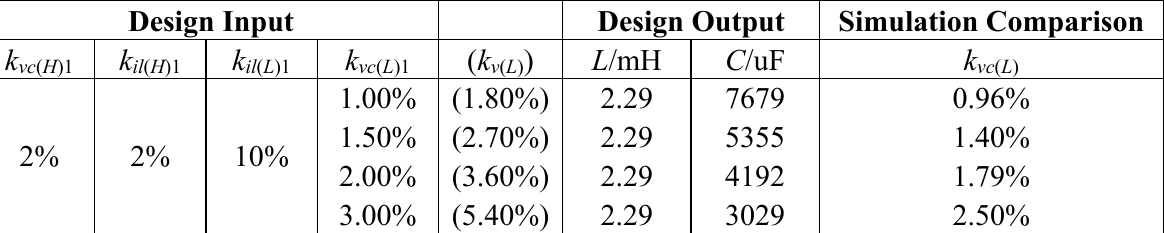
Table 2. Z-Source network design results.